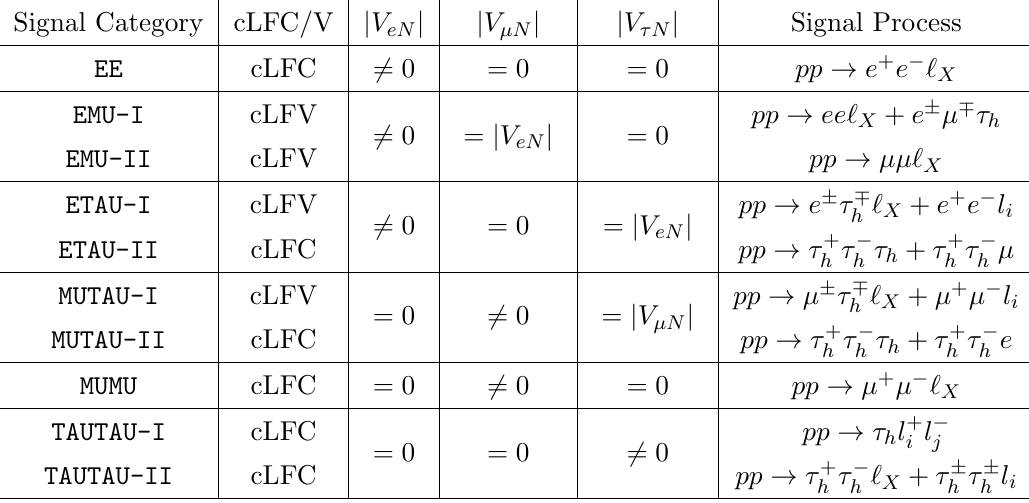
Signal categories for trilepton signal processes mediated by a heavy Dirac neutrino ( N ), underlying mixing hypotheses, whether the signal process is charged lepton (cid:13)avor-conserving (cLFC) or -violating (cLFV). Here ‘ X lepton charges are